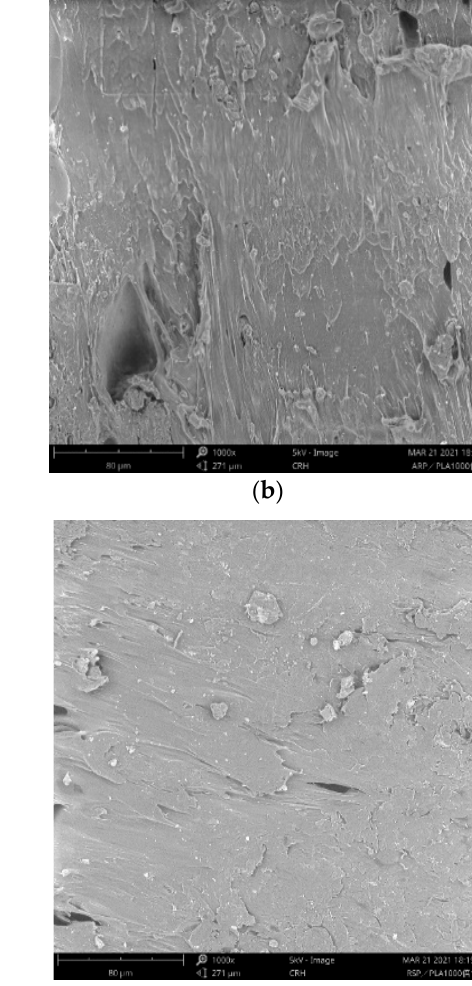
Figure 3. Mechanical properties of FDM 3D ‐ printed specimens ( a ) strength; and ( b ) δ – ε curve.